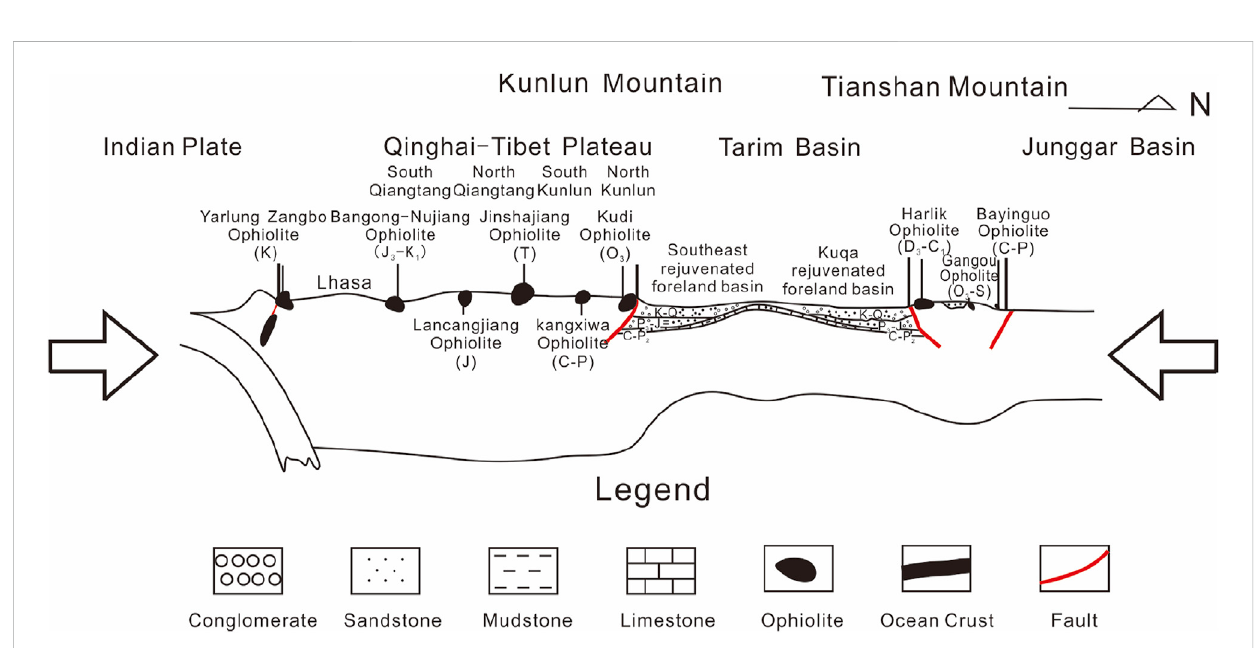
Frontiers in Earth